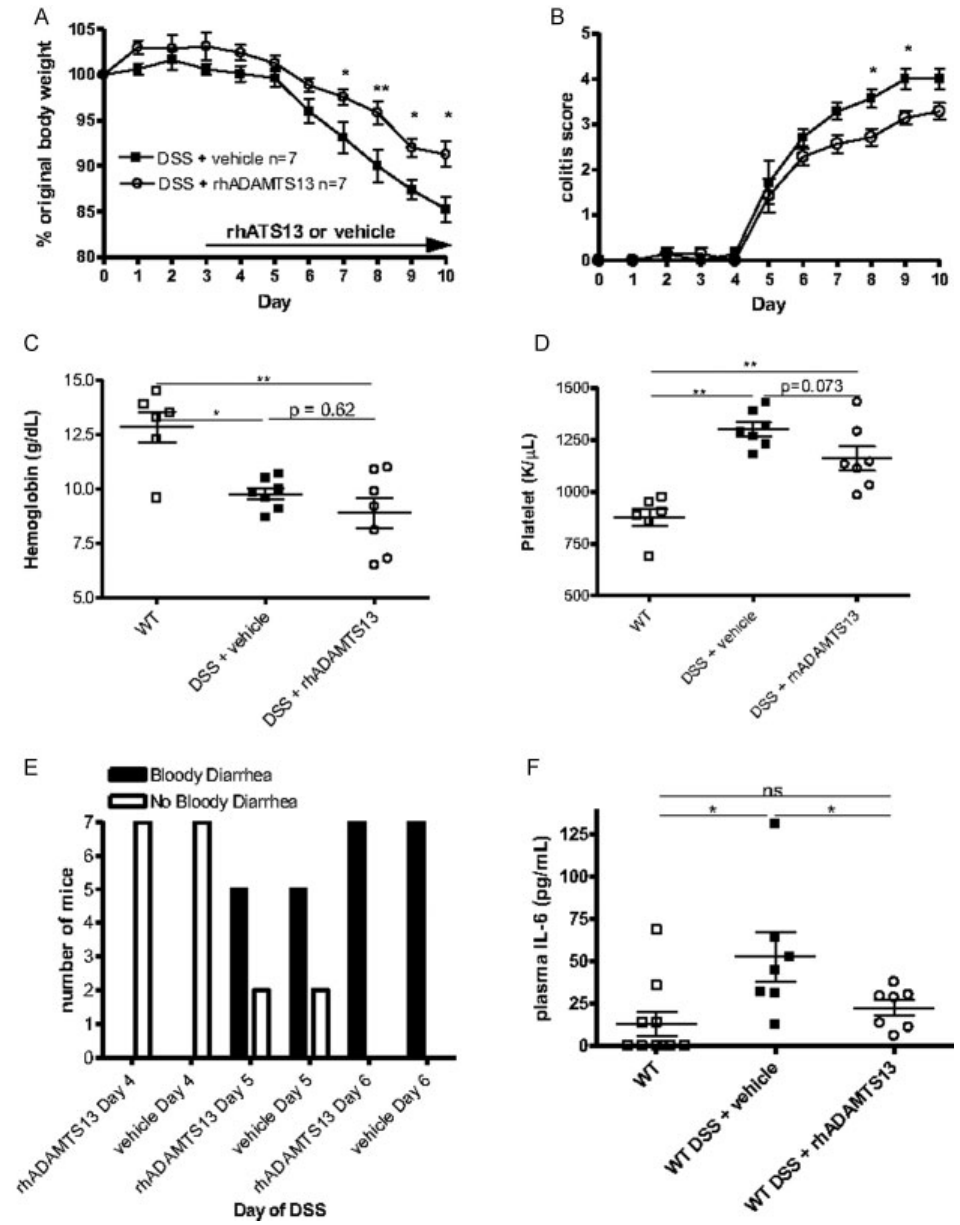
Fig.6 Treatmentof WT mice with rhADAMTS13 improves outcome. ( A ) Percentof original body weight inWT mice withDSStreated withvehicle (squares) or rhADAMTS13 (circles). There was signi fi cantly less weight loss in rhADAMTS13-treated mice on days 7 to 10 when colitis is most severe. ( B ) Colitis scores are more severe on days 8 and 9 in vehicle-treated compared with rhADAMTS13-treated mice. ( C ) Hemoglobin concentration decreases with colitis in both vehicle- and rhADAMTS13-treated mice. However, there is no signi fi cant difference in hemoglobin concentration between the treatment groups. ( D ) Platelet count increased in both groups with colitis but tended to be lower in the rhADAMTS13 treatment group. Five of seven mice in each group developed bloody diarrhea by day 5 and all mice in both groups by day 6. ( E ) There was no difference in the onset of bloody diarrhea in rhADAMTS13- or vehicle-treated mice with DSS colitis. ( F ) Plasma IL-6, a proin fl ammatory and prothrombotic cytokine, was lower in rhADAMTS13-treated compared with vehicle-treated DSS colitic mice. IL-6 also increased with colitis in vehicle-treated mice but did not differ from baseline in rhADAMTS13-treated mice. In all graphs, mean and SEM are shown. (cid:5) p < 0.05, (cid:5)(cid:5) p < 0.005, (cid:5)(cid:5)(cid:5) p <